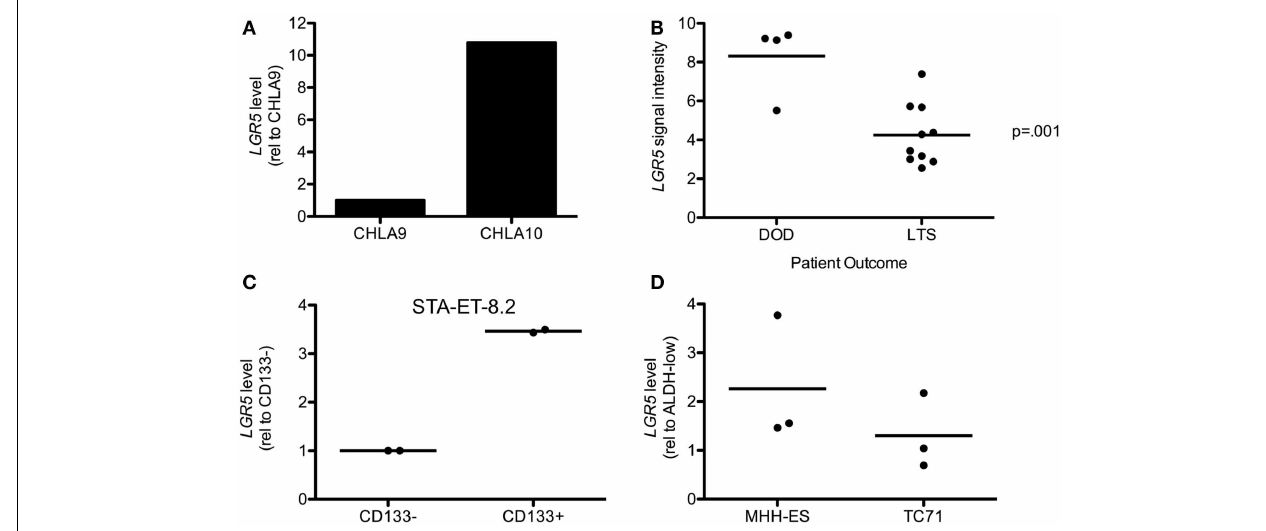
survivors). (C) LGR5 levels are higher in CD133 + compared to CD133 − STA-ET-8.2 cells. Data from two independent sorting experiments are shown and expression on the y -axis is of CD133 + cells relative to the corresponding CD133 − cells. (D) LGR5 expression is increased in ALDH high compared to ALDH low MHH-ES andTC71 cells. Data from three independent sorts are shown and expression on the y -axis is that of ALDH high relative to the corresponding ALDH low cells.The horizontal line in (B–D) all represent arithmetic mean